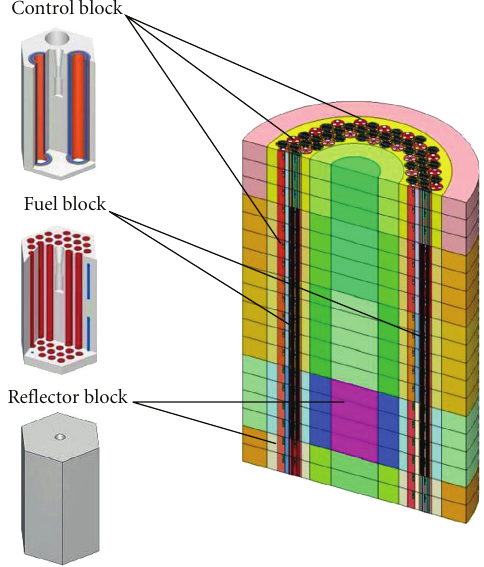
Figure 3: 3D whole-core model of the reference VHTR configura-